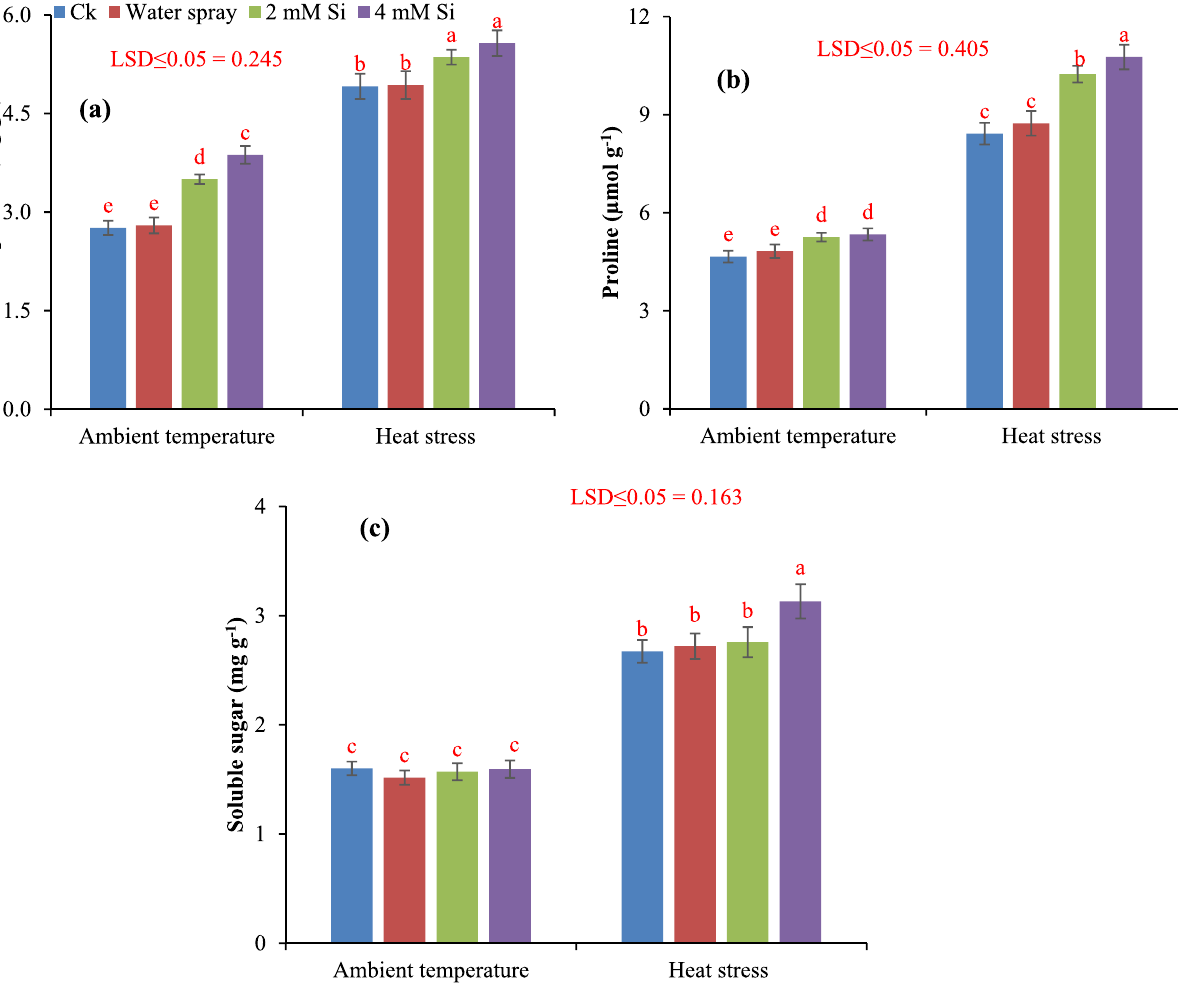
Figure 5. Influence of exogenously applied Si on soluble protein ( a ), proline ( b ) and soluble sugar ( c ) of wheat under ambient temperature and heat stress. Values are the mean SE of four